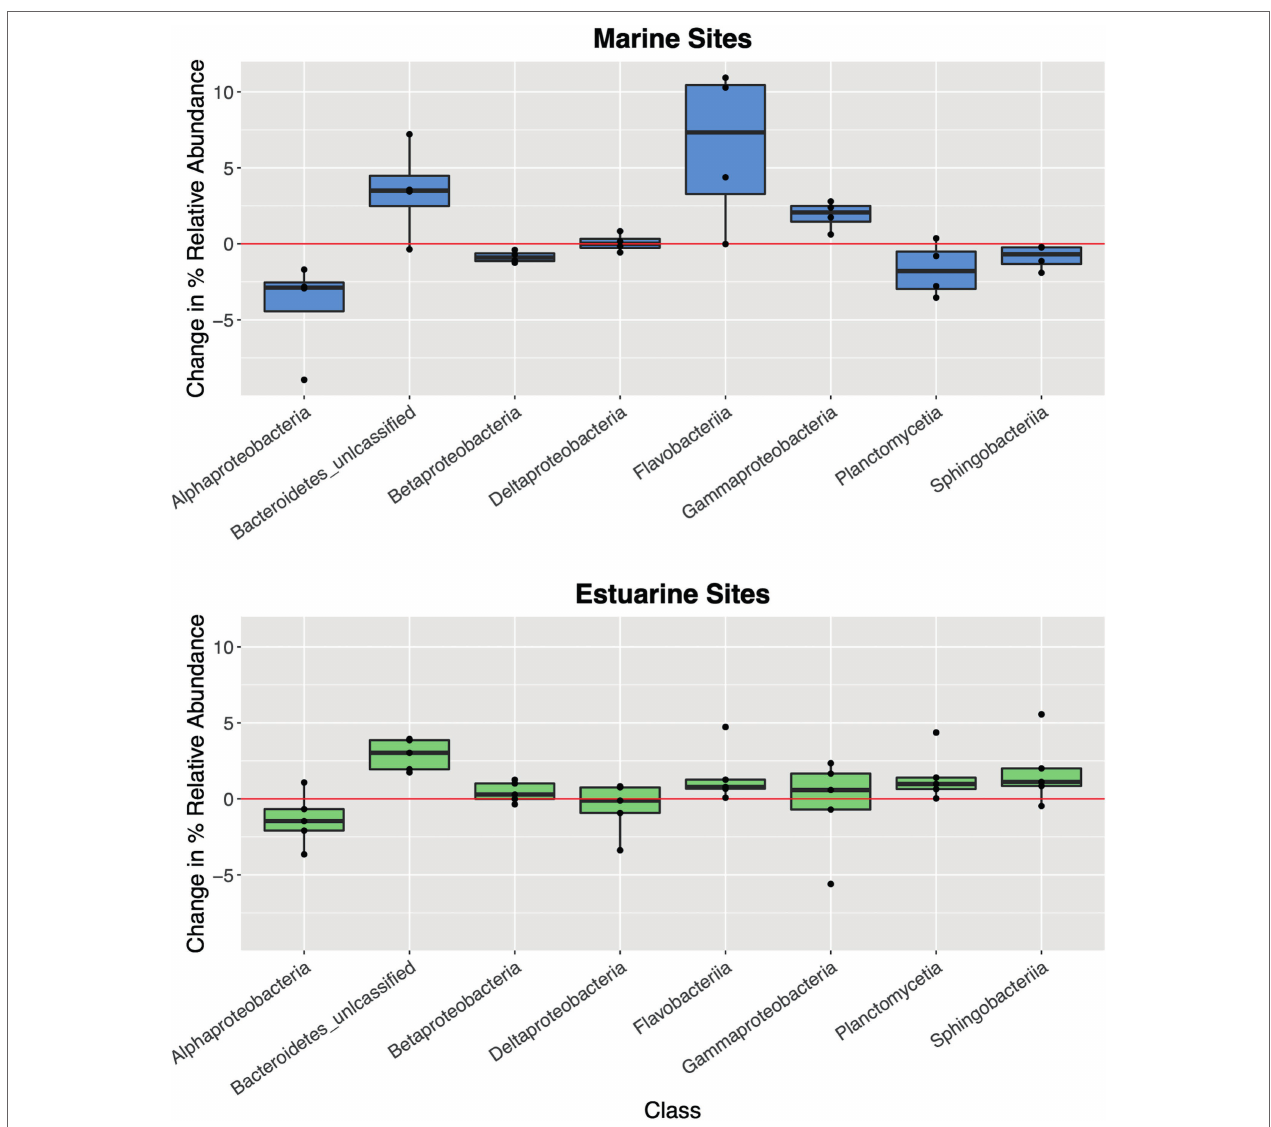
FIGURE 6 | Boxplots of site-specific changes to microbial community composition in correlation with the 2018 hurricane season. Each data point represents difference in percent relative abundance of select taxonomic groups between sampling sites during the 2018 hurricane season and geographically similar sampling sites from 2019. Red line represents no change in percent relative abundance. Positive abundance values represent taxa that were more abundant during 2018 hurricane season, while negative abundance values represent taxa that were less abundant during 2018 hurricane season. Marine sites (>25 ppt, blue boxes) had higher proportion, or relative abundance of Flavobacteriia , Gammaproteobacteria , and unclassified Bacteroidetes while having lower relative abundance of Alphaproteobacteria in surface waters compared to non-hurricane conditions. Hurricane-influenced estuarine sites (<25 ppt, green boxes) were generally characterized by smaller changes in site-specific relative abundance, but nonetheless showed increased relative abundance of unclassified Bacteroidetes and decreased relative abundance of Alphaproteobacteria compared to non-hurricane